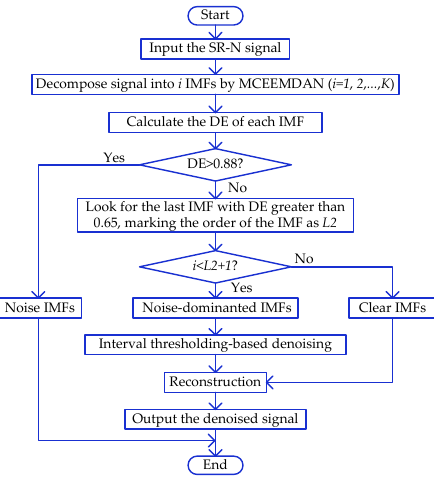
Figure 1. The flowchart of the proposed method.